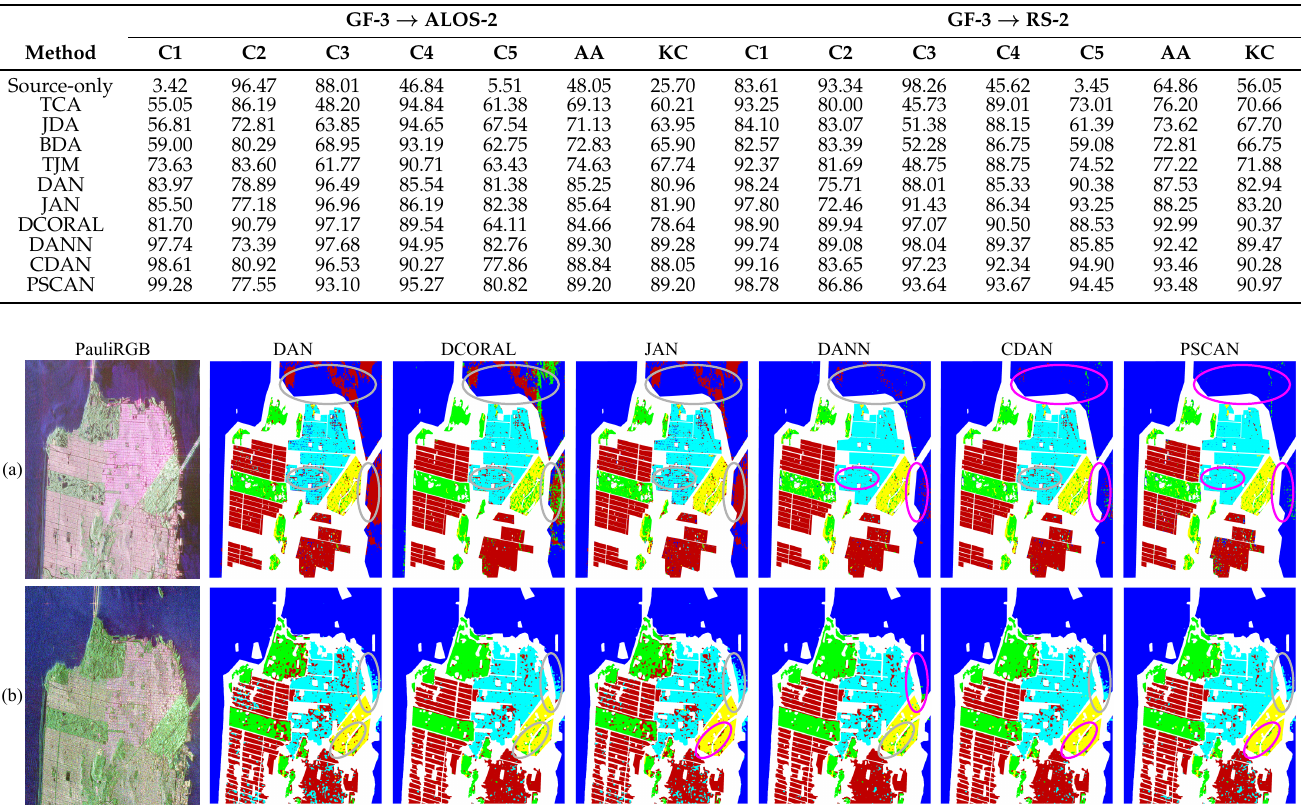
Figure 9. Comparison of the whole map classification results on the San Francisco area when the source domain is set to GF-3. The circles in pink and gray represent the correct and incorrect classification, respectively. ( a ) ALOS-2 as the target domain. ( b ) RS-2 as the target domain.